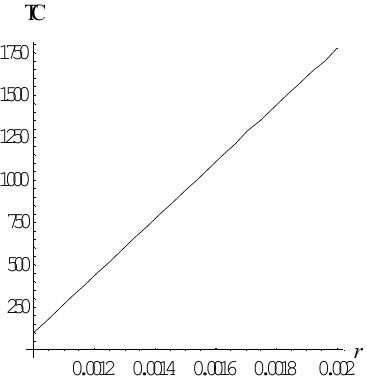
Fig. 9. (b) The effect of parameter r on the total cost in the fuzzy